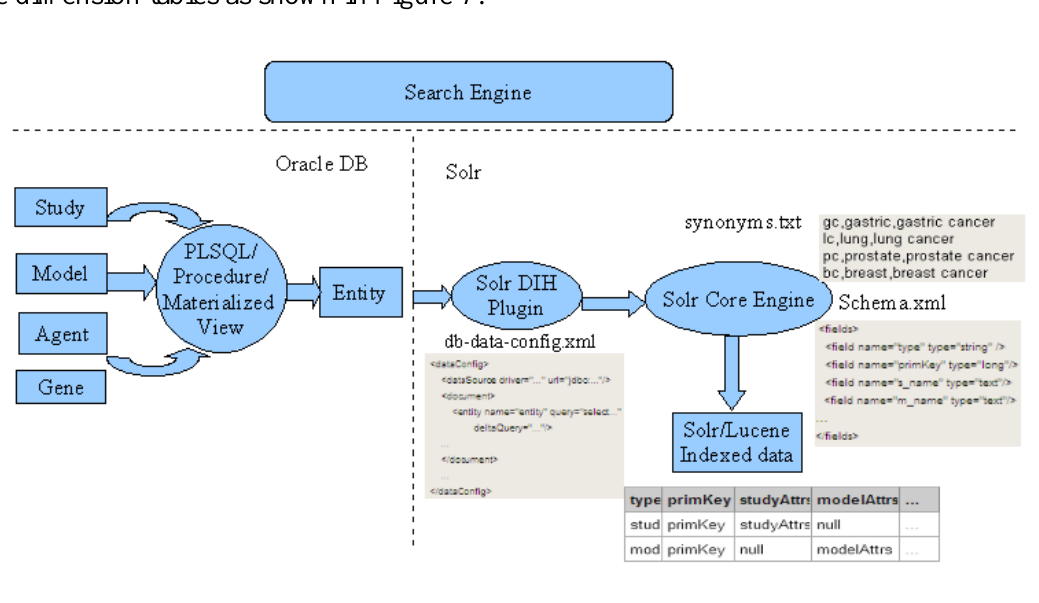
Figure 5: Full-text search data architecture